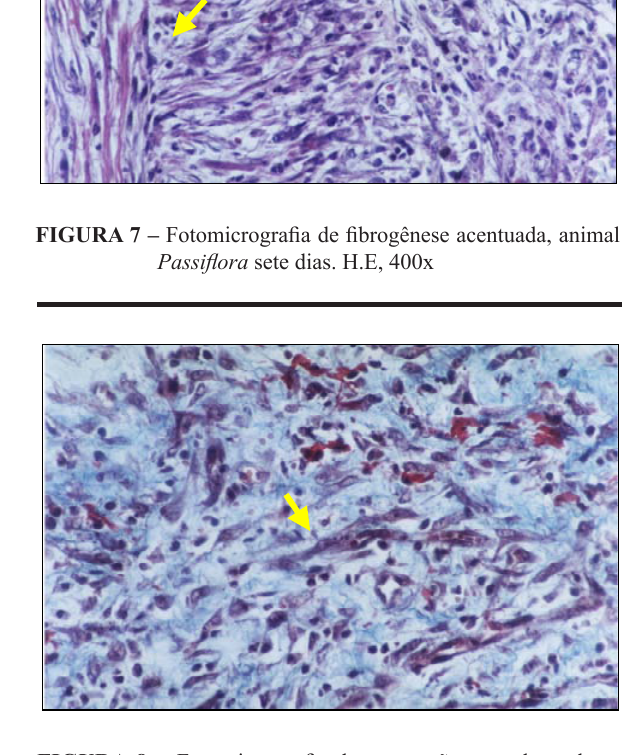
FIGURA 8 – Fotomicrografia de congestão vascular, edema moderado e fibrogênese discreta, animal controle sete dias. Tricômico de Masson,